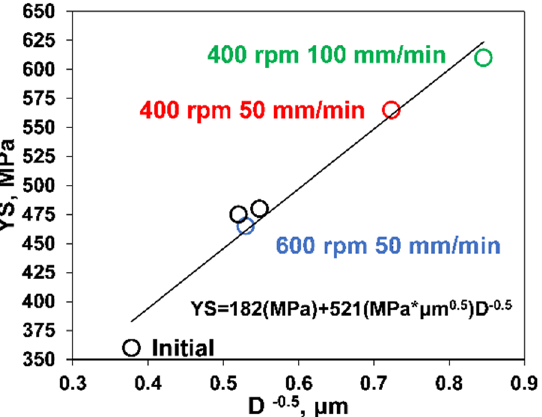
Figure 9. Hall–Petch relation of the yield strength (YS) on grain size in the Fe 49 Mn 30 Co 10 Cr 10 C 1 al-